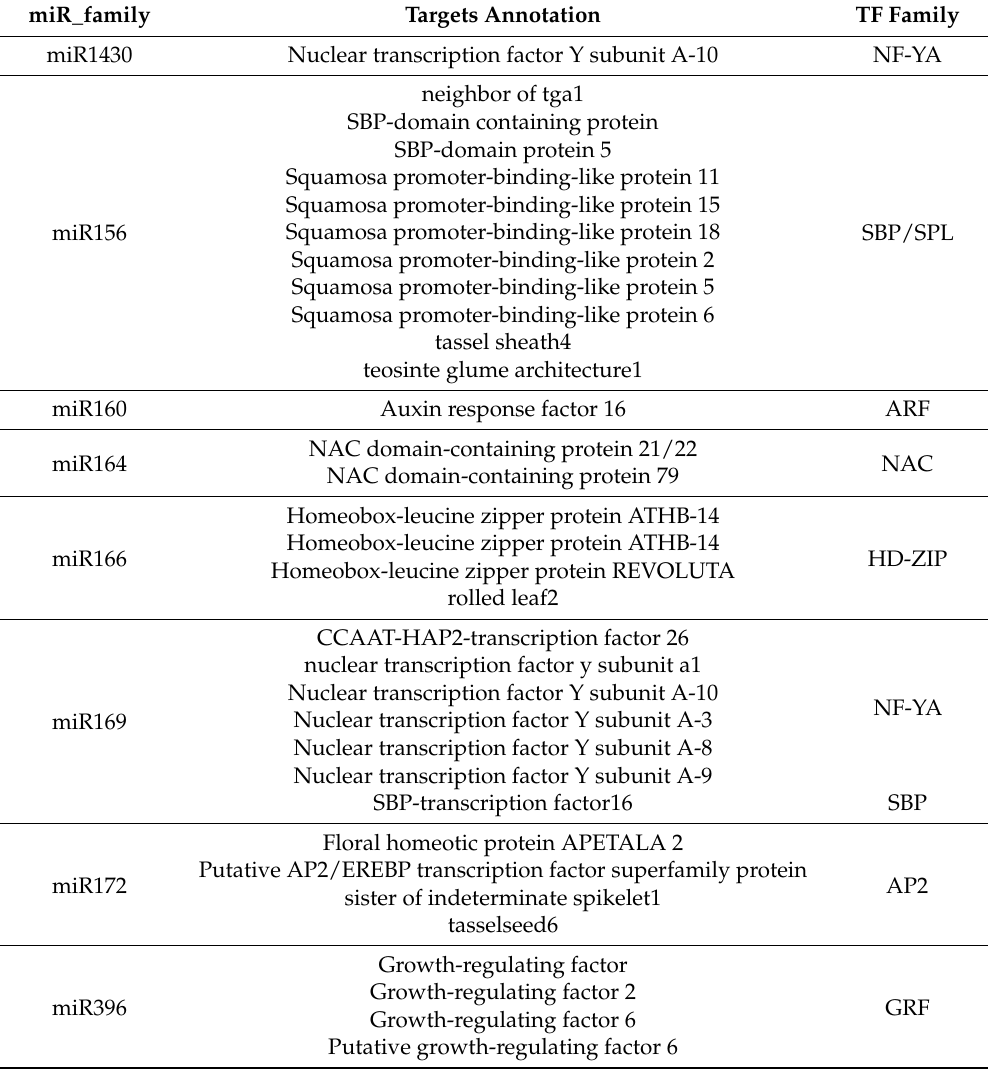
Table 1. Identified target transcription factors of known DEMs by degradome analysis.